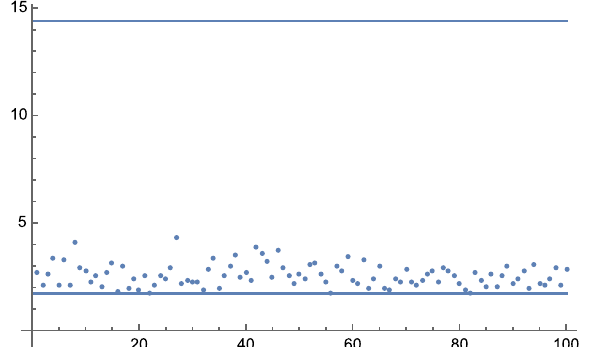
Fig. 14 The variances V [ F ] of Example 5 computed for 100 independent executions with the linear heuristic, using a total of 100 samples for each technique. The horizontal lines correspond to the optimal and the equal sampling budget variances, respectively